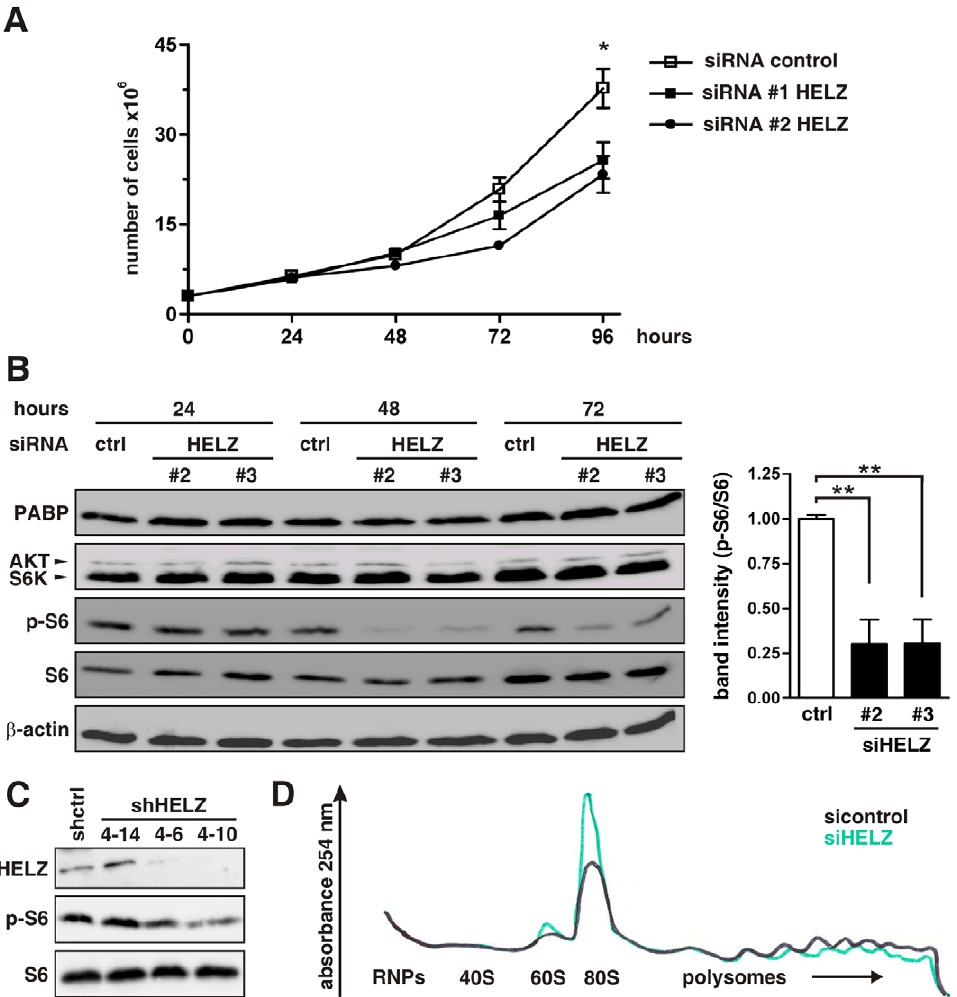
Figure 6. HELZ suppression limits cellular proliferation, ribosomal protein S6 phosphorylation and initiation of translation. ( A ) HeLa cells were transfected with the indicated siRNA oligonucleotides and cell numbers were assessed every 24 hours using an automated cell counter. ( B ) Immunoblot analysis of HeLa cells transfected with two different HELZ siRNA oligonucleotides and harvested at indicated time points after transfection (left panel). The experiment was performed three times independently and the pS6 band intensities were quantified 48 hours after transfection (right panel). ( C ) Protein levels of HELZ, p-S6 and total S6 in stable shRNA control (shctrl) or shRNA HELZ expressing cells were analyzed by immunoblotting. ( D ) Representative polysomal profile (n=3) of HeLa cells transfected with control or HELZ siRNA oligonucleotides.